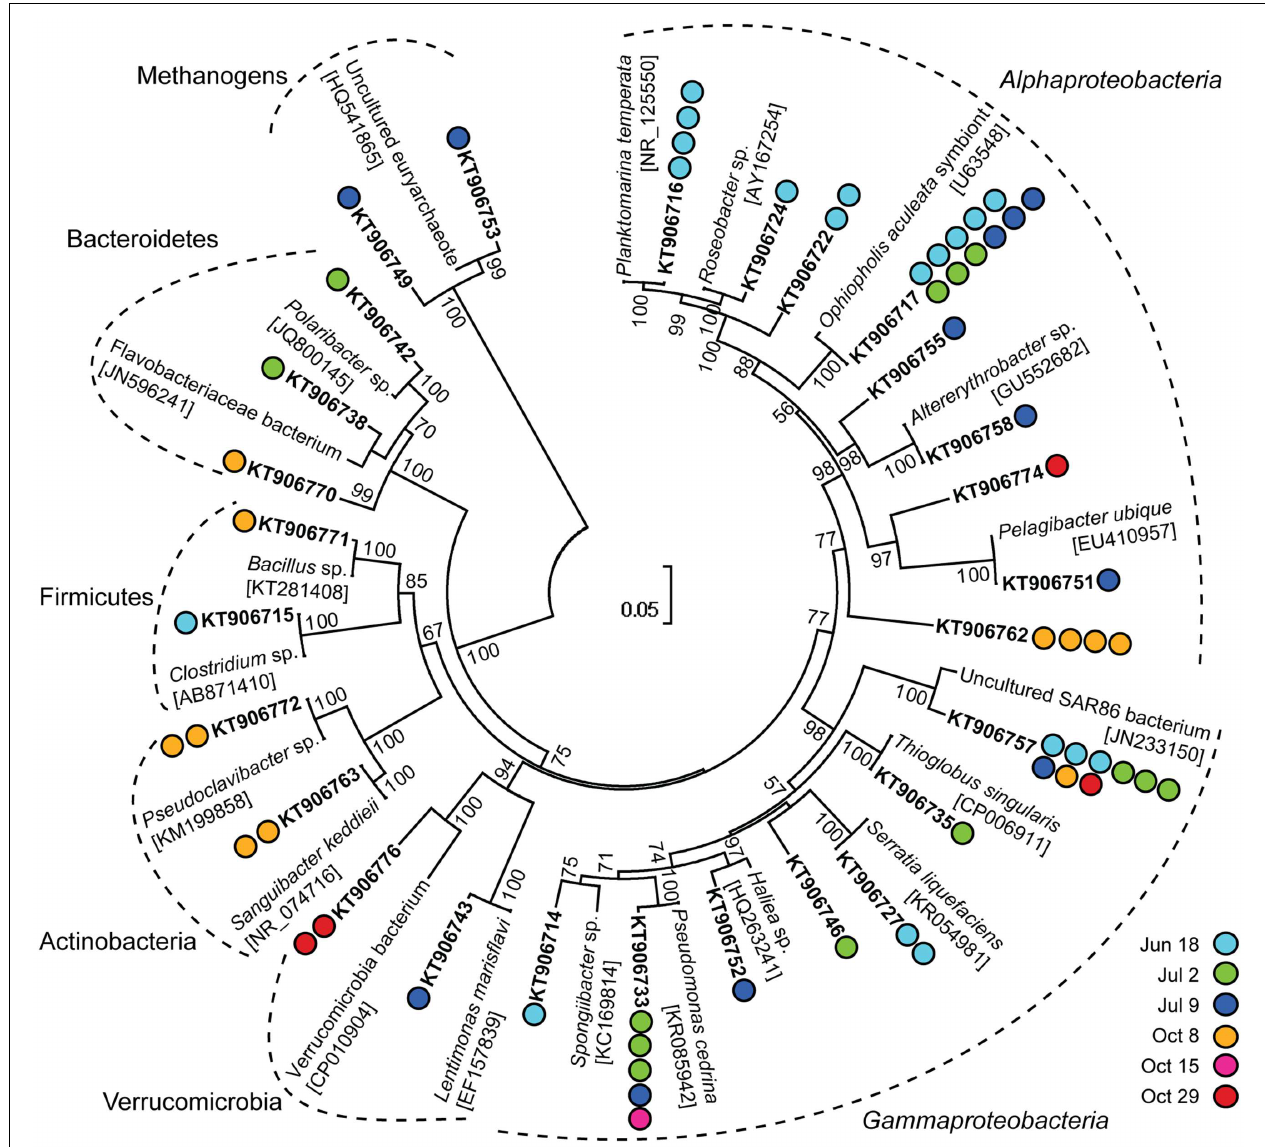
FIGURE 2 | Neighbor-joining phylogenetic tree of 97% similarity clustered non-Eukaryota sequences in 16S rRNA gene clone libraries from photosynthetic picoeukaryote cell sorts (P1, 1,000 cells) and their closest relatives. GenBank accession numbers are written in square brackets for the closest relatives and in bold for the representative clones. Colored circles indicate the number of sequences in each cluster and the corresponding date for each clone. Bootstrap values > 50% (1,000 replicates) are indicated next to the node.